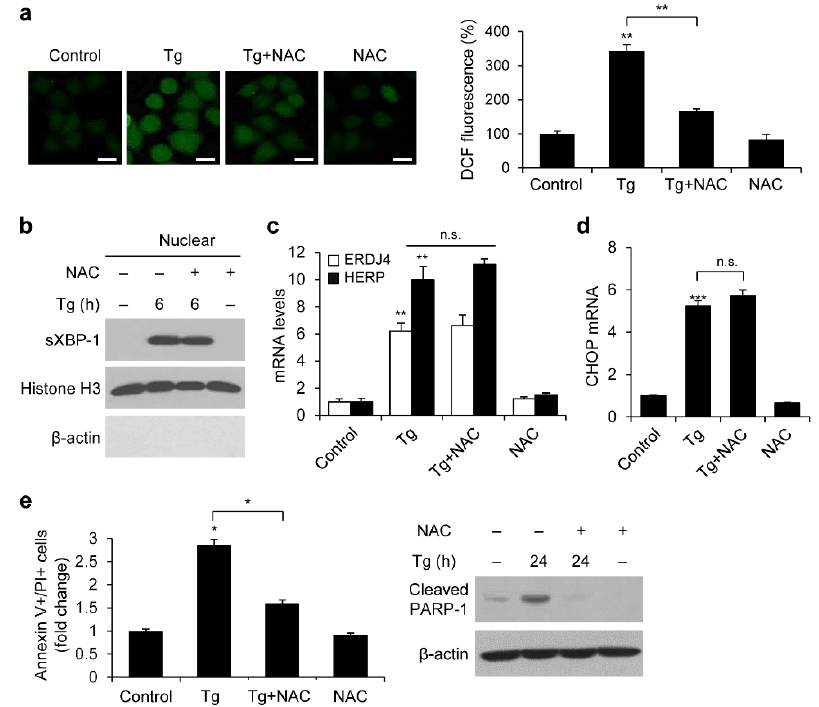
Figure 5. ROS production by ER stress is associated with enhanced apoptosis; however, it does not affect UPR and CHOP activation. ( a ) HeLa cells were treated with 5 mM NAC or/and 300 nM Tg for 12 h. Intracellular ROS were measured by DCF ‐ DA staining using confocal microscopy. The DCF fluorescence intensity was assessed using Image J software. Scale bar, 20 μ m. ( b ) WB of nuclear fractions in HEK293 cells treated with 5 mM NAC or/and 300 nM Tg for the indicated time. ( c , d ) The mRNA levels of ERDJ4 and HERP ( c ) or CHOP ( d ) in HEK293 cells treated with 5 mM NAC or/and 300 nM Tg for 12 h analyzed using qRT ‐ PCR. The mRNA levels are shown as fold changes compared with control vector cells. ( e ) WB of cleaved PARP ‐ 1 in HEK293 cells treated with 5 mM NAC or/and 300 nM Tg for 24 h. Data are expressed as the mean ± SD of three independent experiments (* p < 0.05, ** p < 0.01, and *** p < 0.001). n.s. not significant.